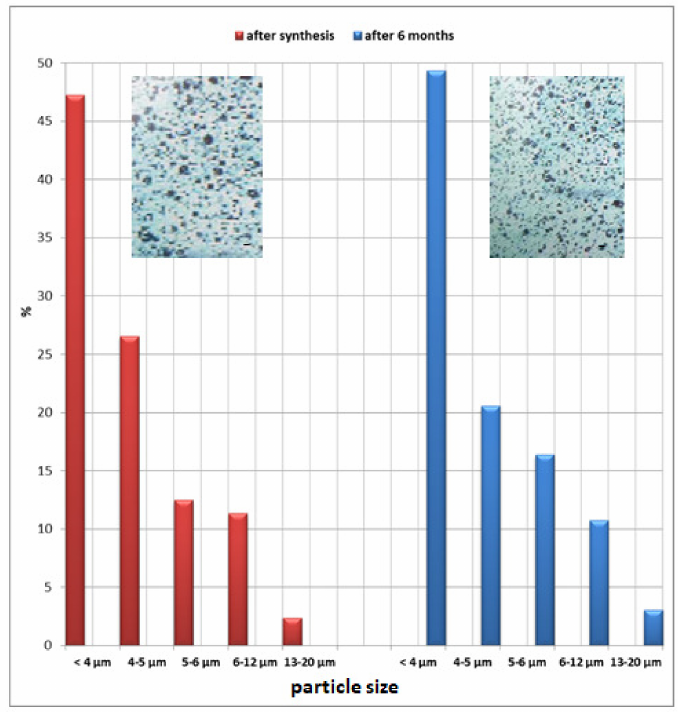
Figure 4. Size distribution of chitosan microparticles (scale bar: 50 µ